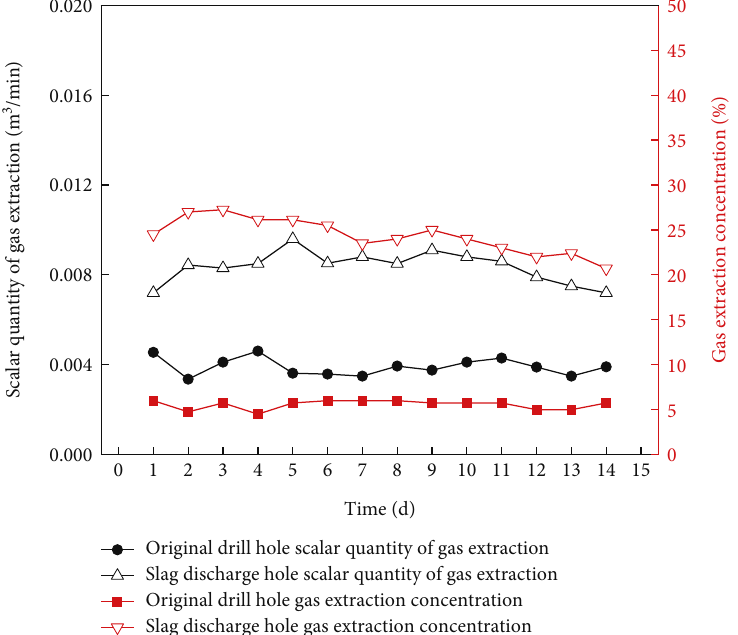
Figure 6: A comparison of the concentration of extracted gas and quantity of gas extraction in the deep drill